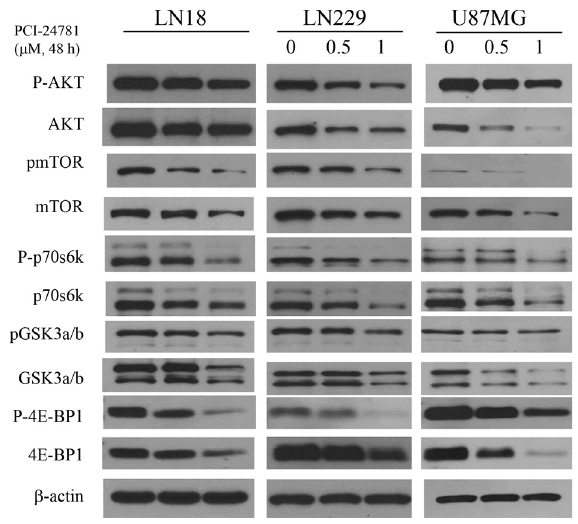
Figure 4 - EZH2 gene silencing promotes cell apoptosis. (A) Flow cytometry results showing apoptosis in three malignant glioma cell lines transfected withEZH2siRNA.(B)Enhancedexpressionoftheapoptosis-relatedproteinscleavedPARPandcaspase3afterknockdownofEZH2.KD–knockdown, NC – normal control (cells with scrambled siRNA), SIR – cells treated with specific siRNA.